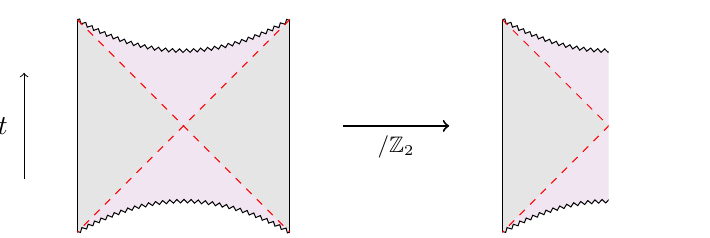
Figure 3 . The Penrose diagram for the maximally-extended, two-sided BTZ, with one of the spatial dimensions ( φ in AdS-Schwarzschild (2.32)) suppressed. Each gray patch is an exterior region, while the purple patches comprise the interior. This geometry exhibits a Z in our calculations. Specifically, we only need to work within a single exterior